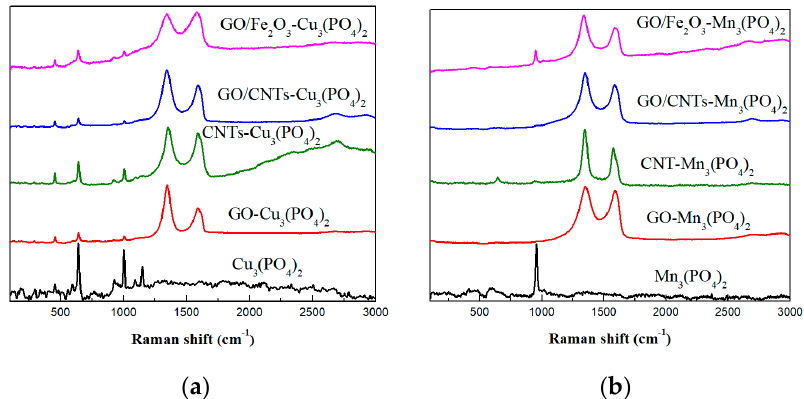
Figure 2. Raman spectra of: ( a ) Cu 3 (PO 4 ) 2 -based CaLB-HNFs and ( b ) Mn 3 (PO 4 ) 2 -based CaLB-HNFs.